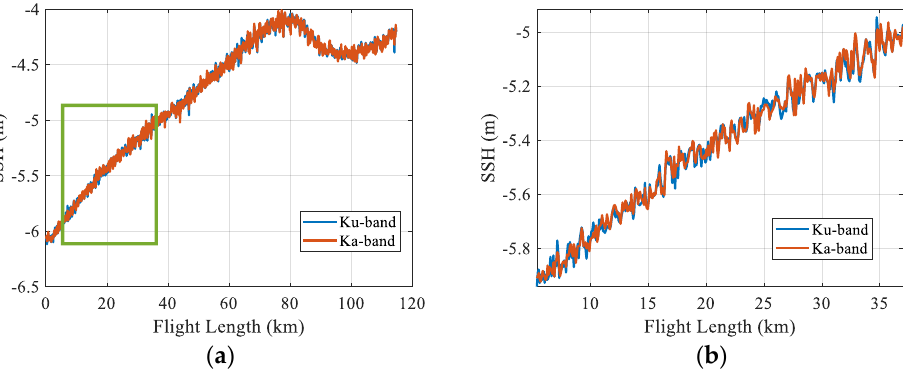
Figure 12. The SSH retrieval results of Ku-band (blue curve) and Ka-band (red curve). ( a ) The complete SSH retrieval results. ( b ) The enlarged section that is indicated in Figure12a.